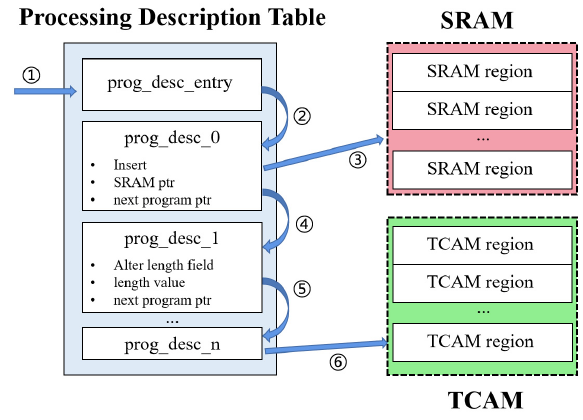
Figure 3. Example of PDT processing.